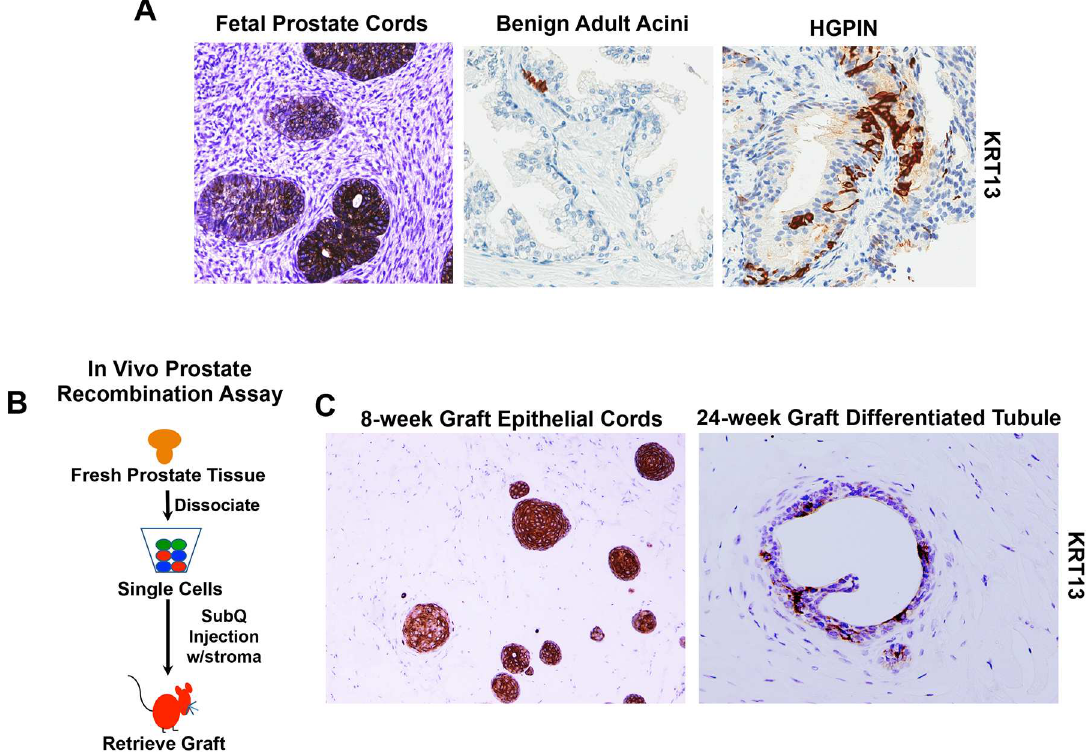
Fig 2. IHC analysis of KRT13 expression in fetal and adult prostate tissue and recombinant grafts. (A) Immunohistochemical(IHC) analysis of fetal prostate tissue, benignadult prostate tissue, and HGPIN lesion. Representative images of fetal tissue 14–18 weeks gestationare shown. KRT13+ Benign and HGPIN lesions were routinely observedin radical prostatectomy specimens. (B) Schematic of in vivo prostate recombination assay. All grafts were generatedfrom freshly dissociatedprostate cells combinedwith hFPS and injected subcutaneously with Matrigel ™ in vivo . (C) IHC analysis of recombinant grafts stained for KRT13. 8-week graft demonstrates predominantly cord-like structures, and 24-week grafts demonstrate differentiated tubules with lumens. Grafts generatedfrom 3 individualprostate specimens were collected at each time period ( < 12 weeks and > 24 weeks). Representative images of KRT13 expression are shown.